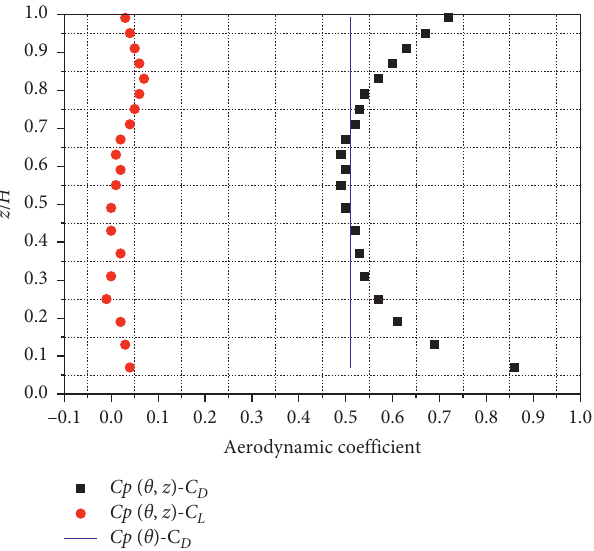
Figure 7: Aerodynamic coefficients at each section.